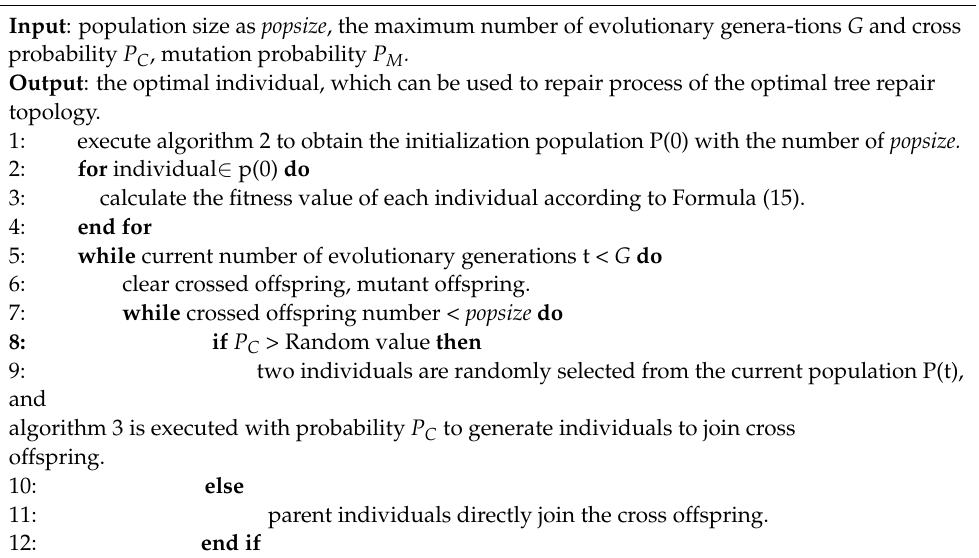
Algorithm 6 Optimal topology construction method based on Hybrid Genetic